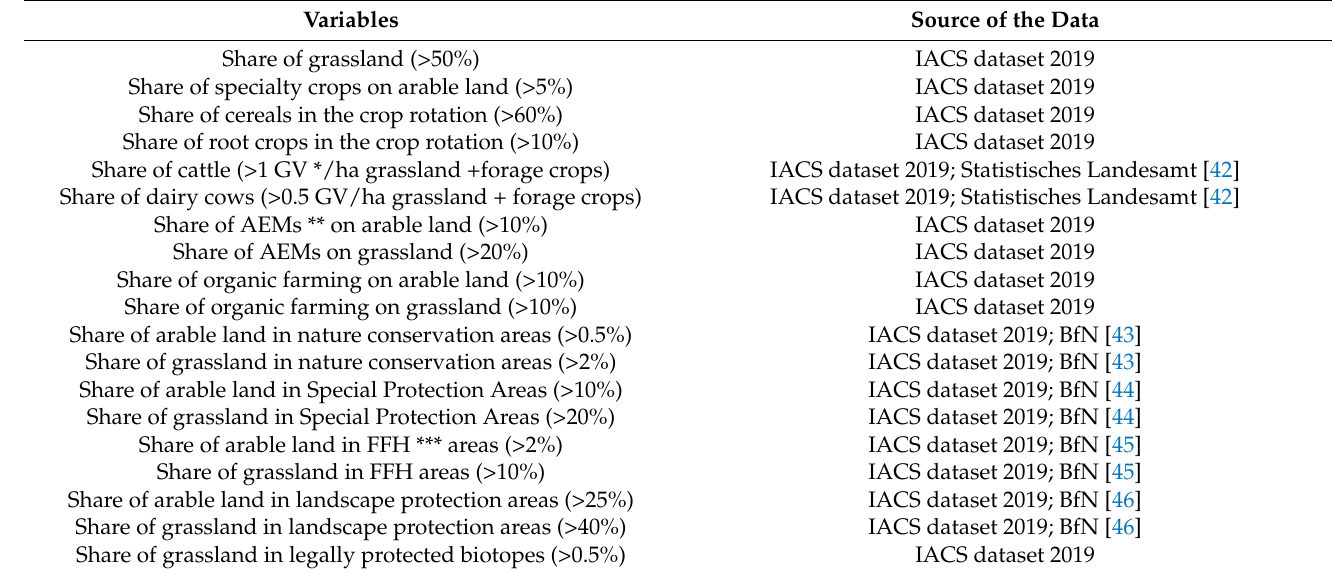
Table 3. Variables used to create the PIC map at the landscape, i.e., municipal level.